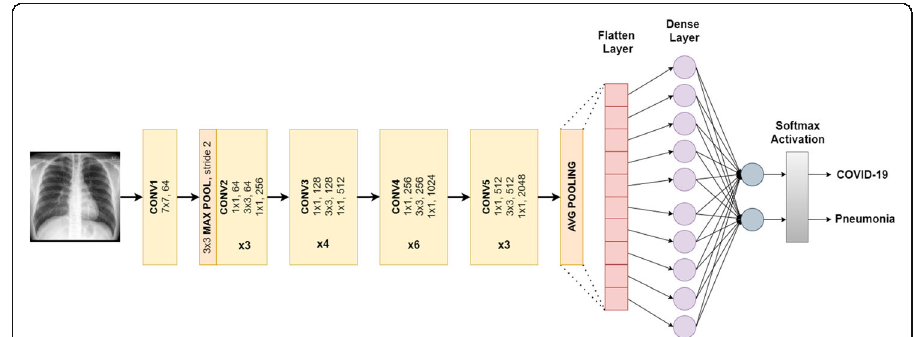
Fig. 6 ResNet50 architecture designed for binary classification